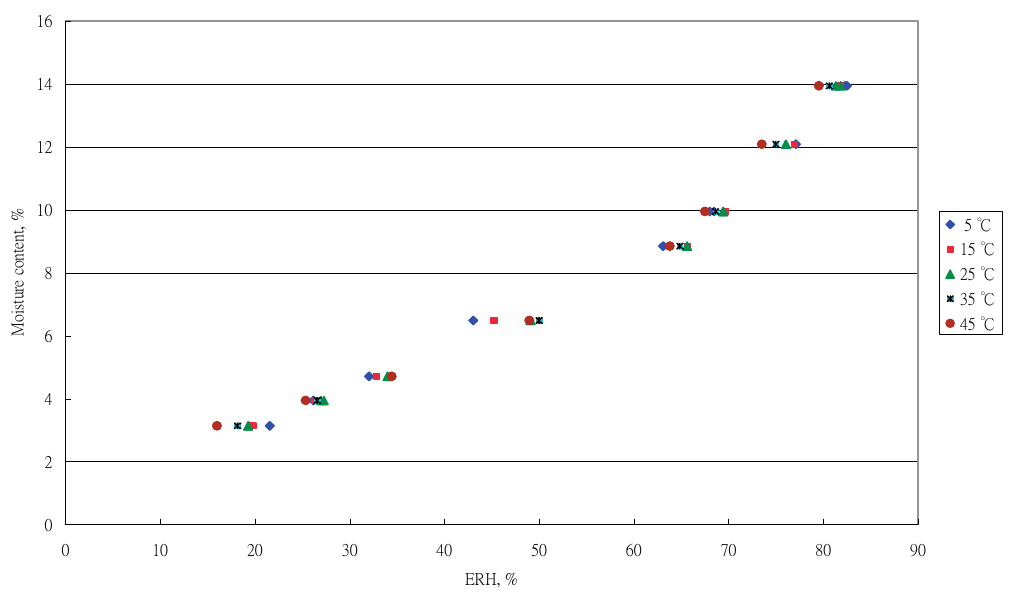
Figure 2. Sorption data for Oolong tea at five temperatures.